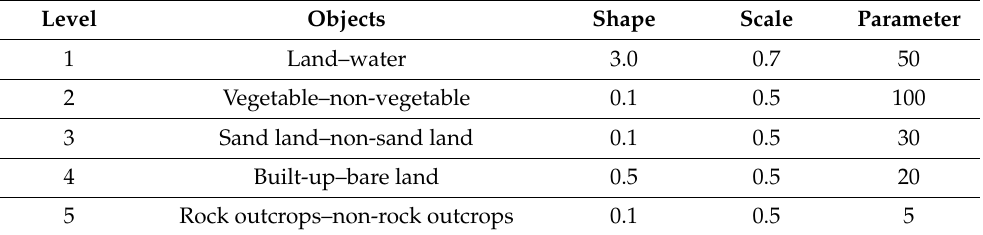
Table 2. Segmentation